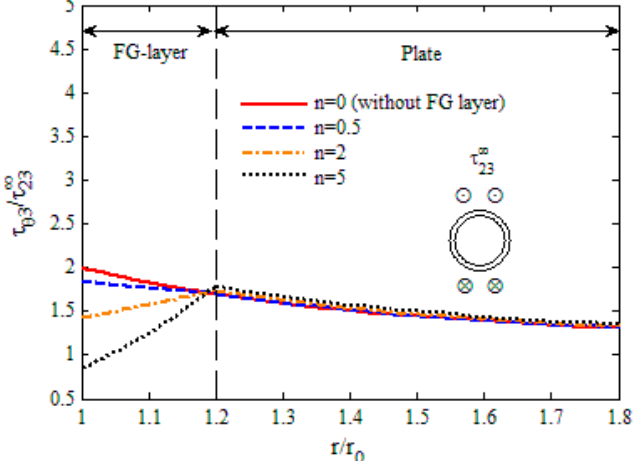
Figure 8. The variation in shear stress τ θ 3 along the normal direction of the hole (circle, δ = 0 ◦ ).